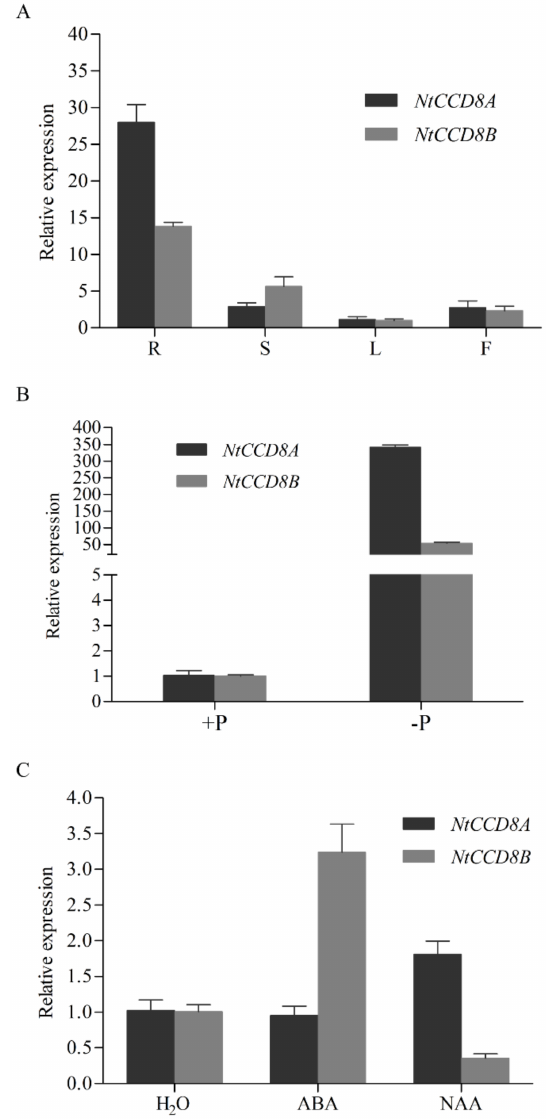
Figure 2. NtCCD8A and NtCCD8B expression patterns in several tissues and in response to stress conditions. ( A ) Relative gene expression of NtCCD8A and NtCCD8B in the several tissues of wild-type tobacco plants: R, root; S, stem; L, leaf; F, flower. ( B ) qRT-PCR analysis of NtCCD8A and NtCCD8B transcript levels in the root tissues of wild-type tobacco plants: in the presence or absence of phosphate (P). ( C ) qRT-PCR analysis of NtCCD8A and NtCCD8B transcript levels in young seedlings treated with 100 µ M ABA and 100 µ M NAA for 6 h. Data are presented as means ± SD. Error bars represent standard deviation of three replicates.